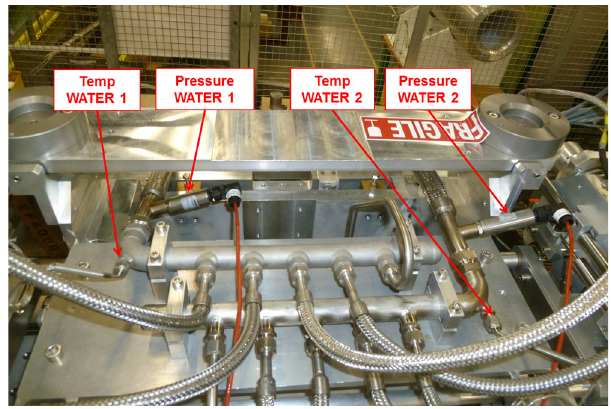
FIG. 6. Top view of the collimator prototype, indicating the location of water temperature and water pressure sensors.